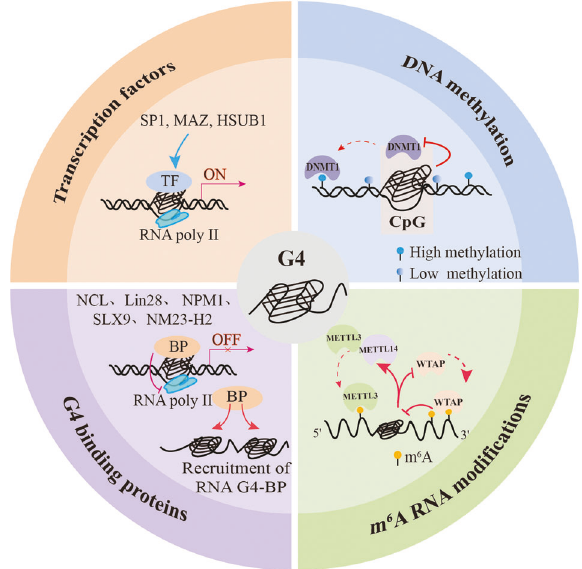
Fig. 2 Factors involved in G4-regulated biological functions. The biological regulation functions of G4s can be affected by transcrip- tion factors (TFs), binding proteins(BP), DNA methylation modi fi ca- tion, and m 6 A RNA modi fi ROS in the formation, stabilization, and regulatory role of G4s will be discussed in the following sections. Role of ROS in G4 Formation and Stability ROS or free radicals such as O 2 (cid:129) − , H 2 O 2, and (cid:129) OH are generated in both hypoxic and hyperoxic conditions [88]. H 2 O 2 decomposes in the presence of Fe 2 + into CO3 (cid:129) − and HO (cid:129) , of which the former is a highly potent oxidizer [89]. The G tracks of G4 structures are highly susceptible to one-electron oxidation by the CO3 (cid:129) − ions [90]. However, it is unclear whether ROS triggers the dissociation of G4s. ROS can reduce the thermal stability of G4 motifs by oxidizing guanine into OG, a common biomarker of oxidative stress [91, 92]. Oxidation of guanine prevents the formation of Hoogsteen hydrogen bonds, which obstructs G4 formation [93] (Fig. 3a, b). However, other studies have reported a stabilizing effect of OG on the G4s. For example, the OG in a G-quartet can be substituted for guanine in the outer G quartets of tetramolecular G4s, thereby increasing its stability [94] (Fig. 3a). Furthermore, recent models of the human telomere indicate a fi fth G track, which could be exchanged with the OG-bearing track to maintain the stability of the fold [95]. Finally, the oxidation of some guanine bases can be compensated by surrounding guanine bases to maintain the stability of G4 [96]. Another study showed that OG could enhance the stability of the G4 structure located in the promoter region of the BCL2, which suggests a potential novel regulatory role of oxidative stress in general, and speci fi cally in BCL2 gene transcription [97]. Thus, the native plasticity of G4s can accommodate structurally perturbing oxidative modi fi cations (Fig. 3c). On the other hand, ROS can also trigger the formation of G4s at transcriptionally active sites containing R-loops [98, 99] (Fig. 3d). Previous reports have demonstrated that ROS induces R-loop formation and facilitate recruitment of R-loop sensors such as RAD52 to the damaged sites [100]. In one study, oxidative damage triggered the formation of R-loop and G4 structures in a BLM helicase-dependent manner [98]. D-loops are located at the 3 ′ overhang of telomeres where G4 motifs are prevalent, and those harboring OG are the preferred substrate for Werner helicase (WRN) compared to the undamaged D-loops [101]. Thus, T a